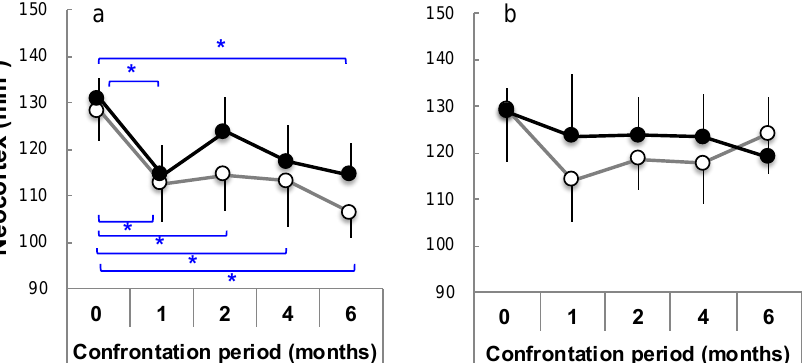
Figure 7. The time course of the neocortex volume in SAMP10 ( a ) and ddY mice ( b ) between the control (open circle) and theanine (closed circle) groups under confrontational housing conditions. The mice were dissected after 0, 1, 2, 4, and 6 months of confrontational housing and subjected to measurement for ex vivo MR (n = 3 – 12; *, p < 0.05) [81].